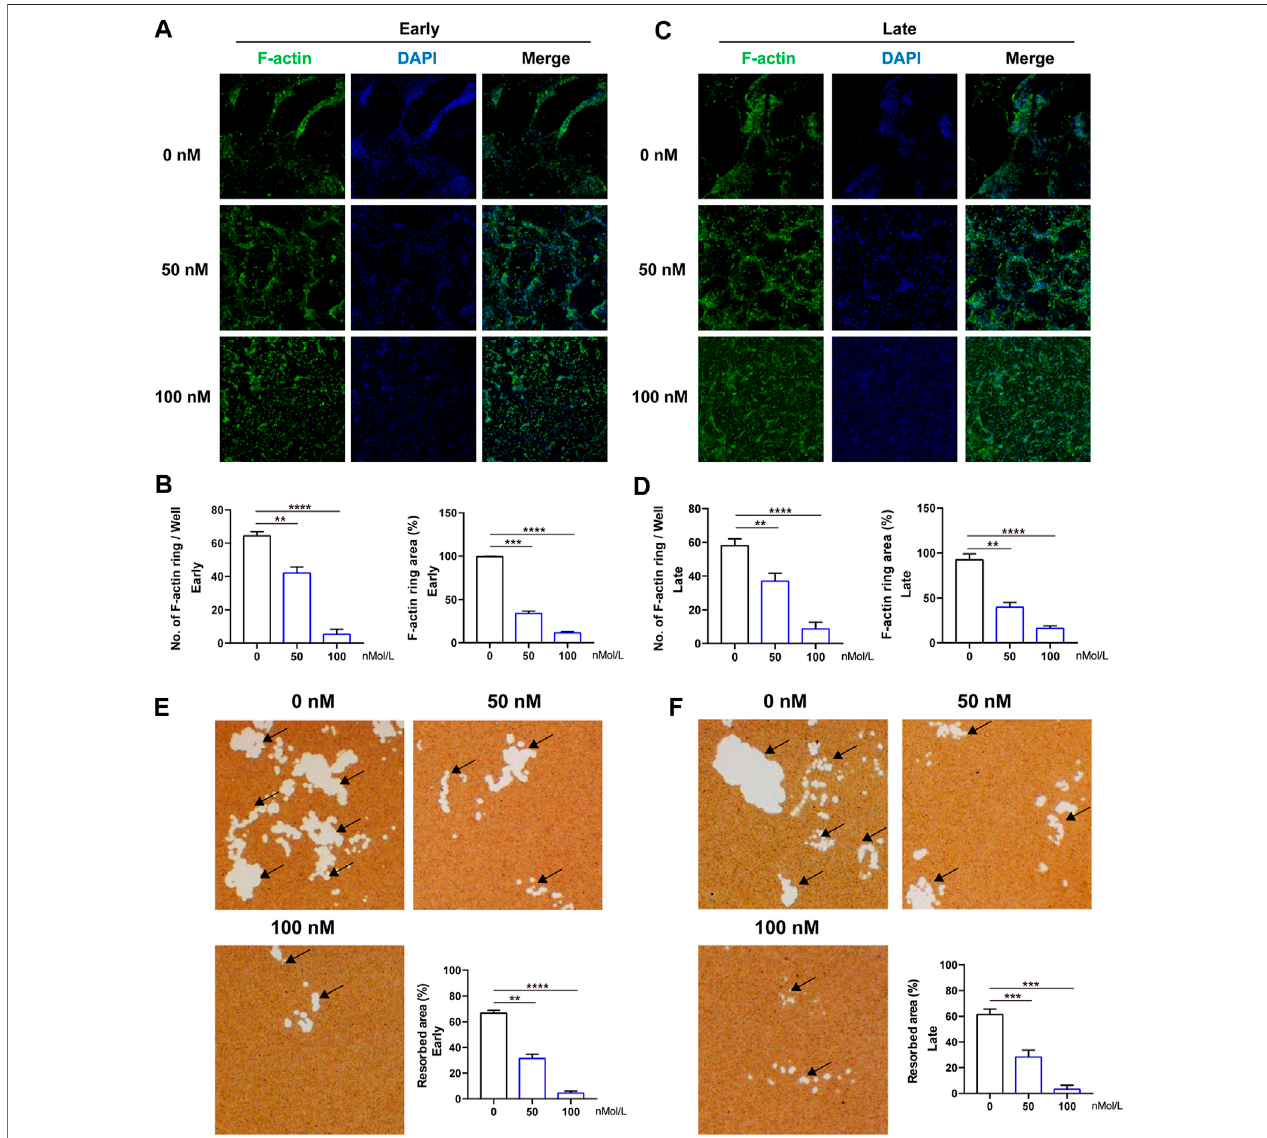
FIGURE3| CS-6 suppresses theformationofF-actin ringand bone resorption ofOCs. (A) Representativeimages ofF-actin (Green)formed byOCsstimulated by RANKL (50 ng/ml) with indicated concentrations of CS-6 (100 nM) for 5 – 7 days. (B) The average number and area of F-actin ring. (C) Representative fl uorescence images of actin-stained BMM-derived OCs stimulated with RANKL (50 ng/ml) for 3 days prior to indicated concentrations of CS-6 (100 nM). (D) The average number andareaofF-actinring. (E) Representativeimagesofboneresorptionpits(whiteareamarkedbyblackarrow)bymatureOCsstimulatedbyRANKL(50 ng/ml)with indicated concentrations of CS-6 (100 nM) for 5 – 7 days and quanti fi ed graph. (F) Representative images of bone resorption pits (white area marked by black arrow) by mature OCs stimulated by RANKL (50 ng/ml) for 3 days prior to indicated concentrations of CS-6 (100 nM) and quanti fi ed graph. Values presented as the mean ± standard deviation ( n (cid:2) 3). * p < 0.05, ** p < 0.01, *** p < 0.001, **** p <